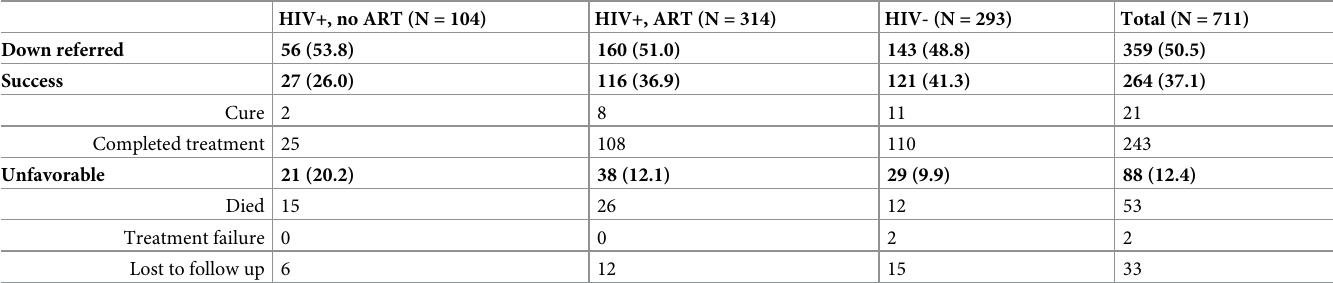
Table 2. TB treatment outcome by HIV and ART status (N =